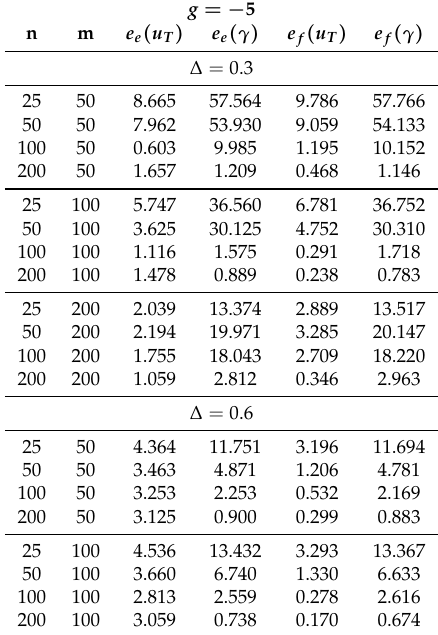
Table 1. One-dimensional problem with erf-smoothing. Relative L 2 error for the temperature at the final time and phase change interface location with respect to the exact solution and a very fine grid